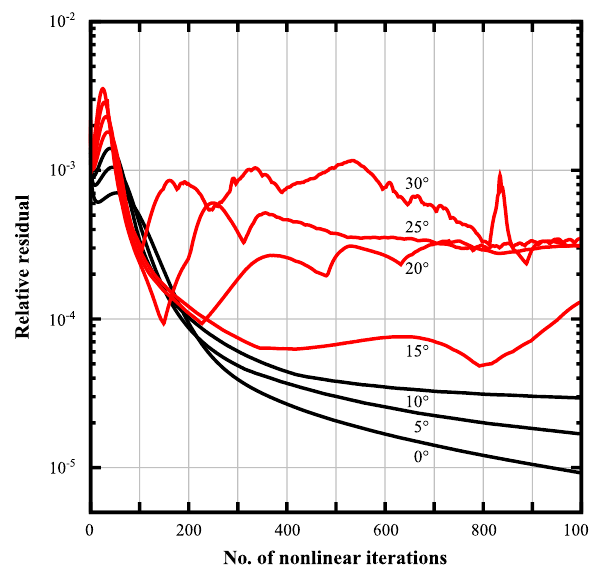
|| U i − U i − i || sup Figure 6. Measured velocity residual ( (cid:15) u = || U i − 1 || sup with U the velocity solution; van den Berg et al., 1993; Kaus, 2010) versus the number of nonlinear iterations for models of extension. Elemen- tal resolution is 512 × 128 elements. Black lines represent runs with well-behaved convergence.